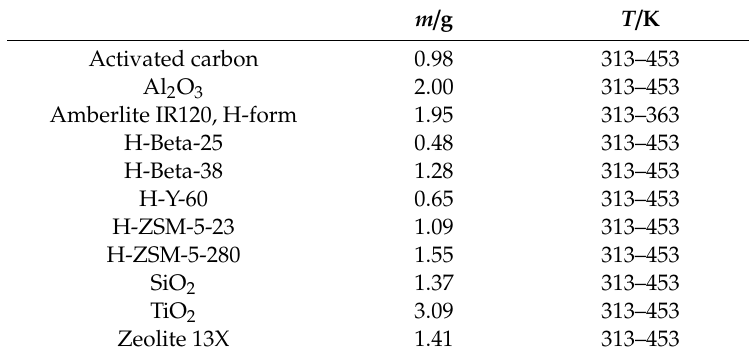
Table 1. Type, Physical Form, Molar Ratio of SiO 2 / Al 2 O 3, and Manufacturer of Catalytic Materials Studied in This Work. Physical SiO 2 / Al 2 O 3 Manufacturer Type Form (mol / mol) Activated carbon activated carbon powder - Chemviron Al 2 O 3 aluminum oxide powder - Acros Organics Amberlite IR120, H-form(53.0–58.0% Ion-exchange resin bead - Acros Organics moisture) H-Beta-25 zeolite powder 25 Zeolyst International zeolite powder 38 Zeolyst International zeolite powder 60 Alfa Aesar H-ZSM-5-23 zeolite powder 23 Zeolyst International H-ZSM-5-280 zeolite powder 280 Zeolyst International SiO 2 silicon dioxide powder - Merck TiO 2 titanium dioxide pellet - Degussa Zeolite 13X zeolite powder 1.8 Fluka Table 2. Loading a ( m ) of Catalytic Materials and Temperature Range b ( T ) of C p Measurement for Each Material. m / g T / K Activated carbon 0.98 Al 2 O